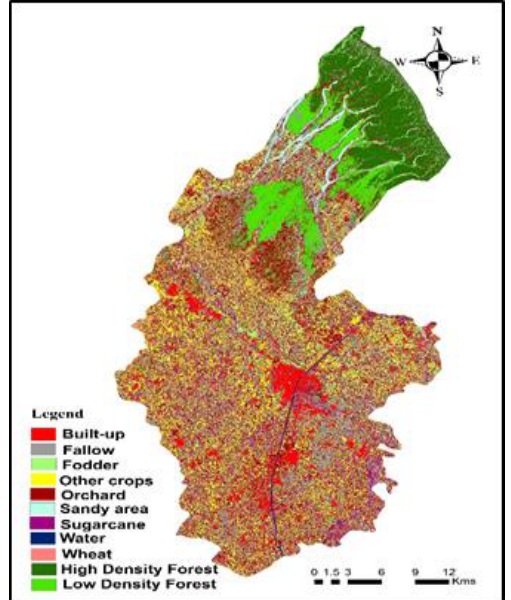
Figure 5 Classified image by